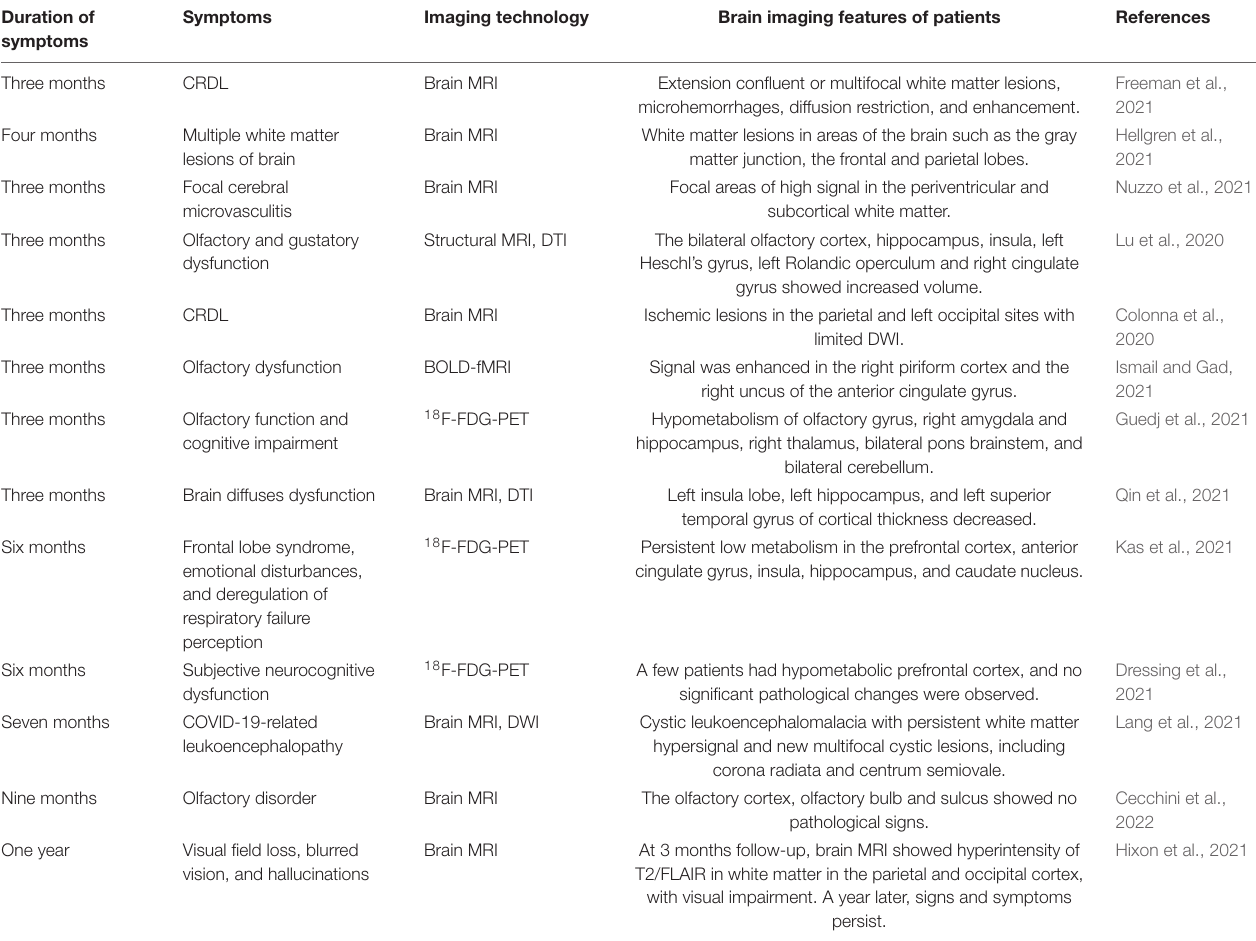
TABLE 1 | Changes in brain microstructure at 3 months, 6 months, and 1 year after